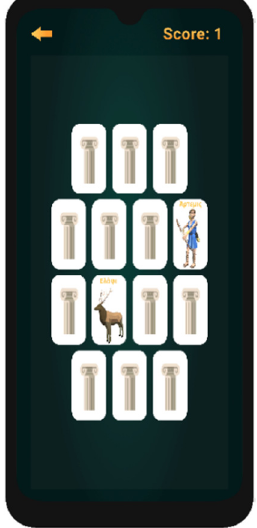
Figure 6. Correct matching of two cards.